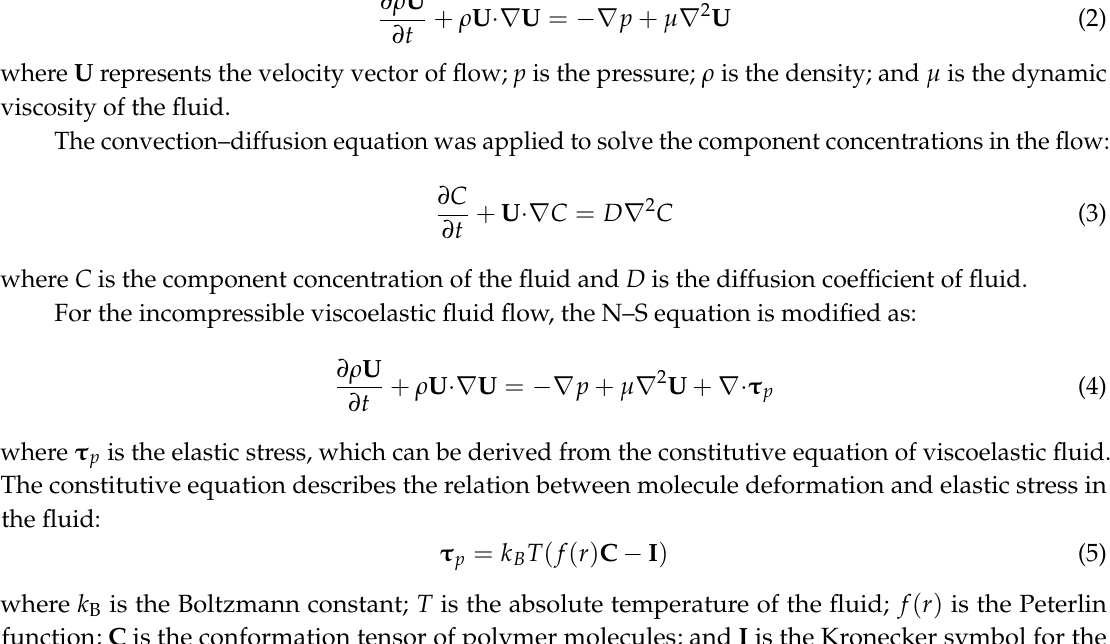
Figure 1. The computational model of T-junction micromixer.